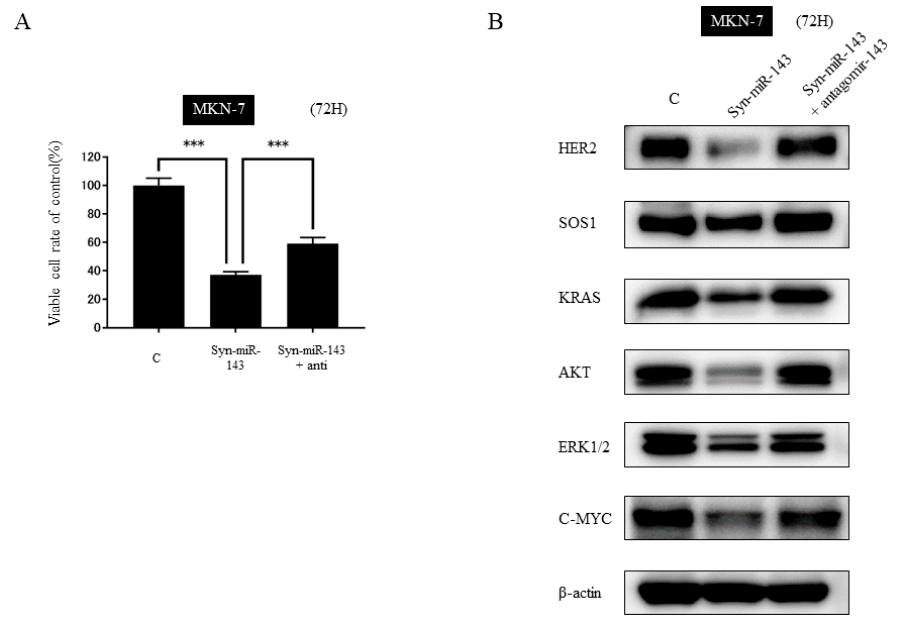
Figure 3. Antagomir assay of miR-143 in MKN-7 cells. ( A ) Cell viability at 72 h after transfection with control RNA alone (5 nM), syn-miR-143 alone (5 nM), or the combination of syn-miR-143 (5 nM) and antagomir-143 (10 nM). ( B ) Western blot analysis of SOS1, KRAS, AKT, ERK1/2, and C-MYC at 72 h after transfection with control alone, syn-miR-143 alone, or the combination of syn-miR-143 and antagomir-143. Results are presented with the mean ± SD; ***, p < 0.001.